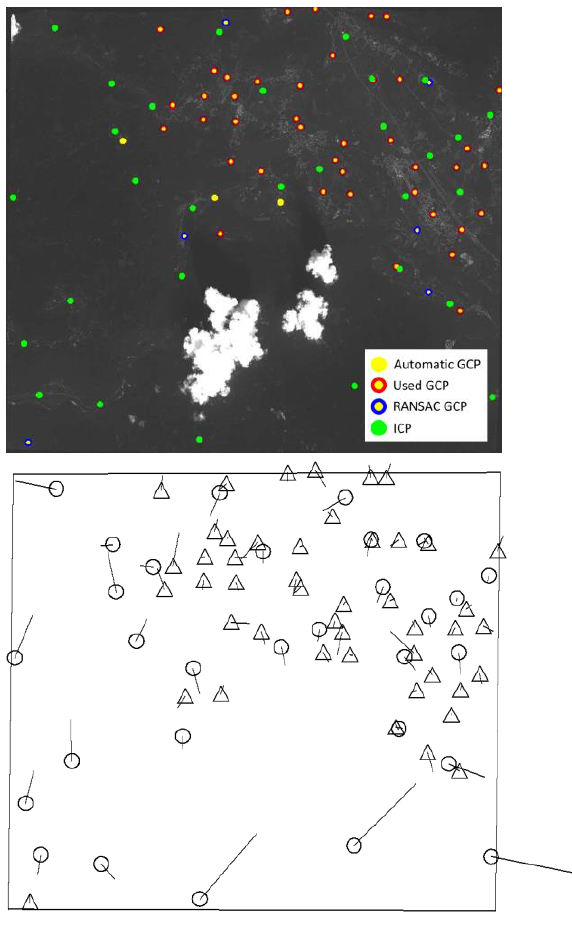
Figure 11. Workflow of the Automatic Topographic Correction Figure 10. Distribution (above) and residuals (below) of automatically extracted GPCs and of manually digitized ICPs on the WorldView-2 image, which was processed by the physical sensor model. On the lower image the dependency of the physical sensor model on distribution of the GCPs is clearly visible – parts of the image without any GCPs (on lower image they are represented as triangles) manifest increased residuals of ICPs (circles).